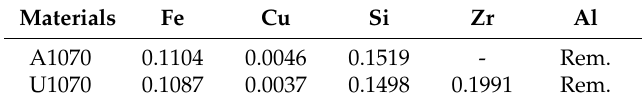
Table 1. Chemical compositions of A1070 and U1070 aluminum alloys (wt %).